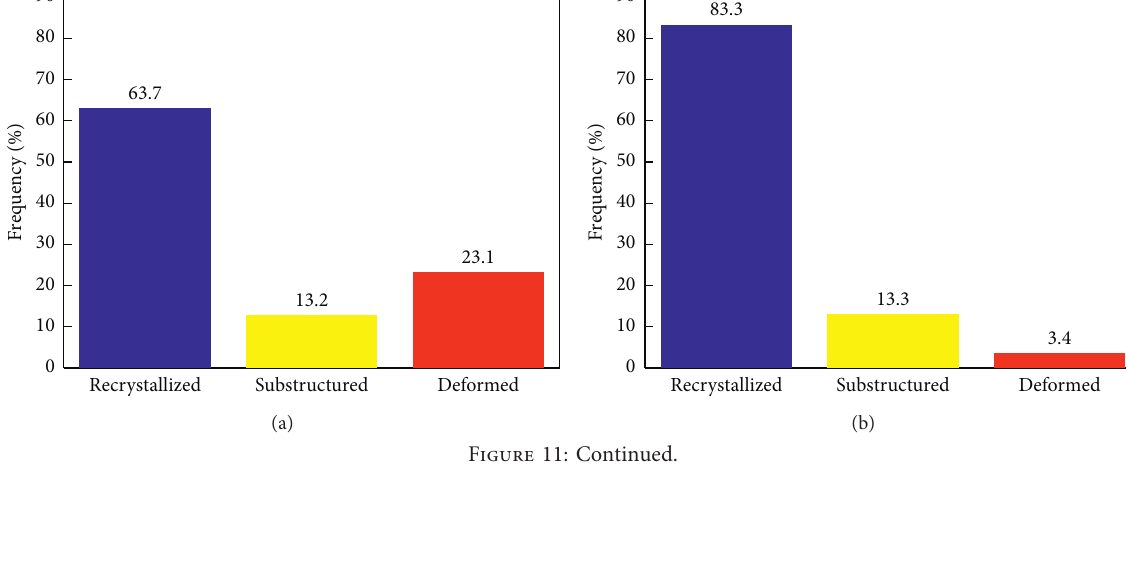
Deformed23.1 Figure 11: